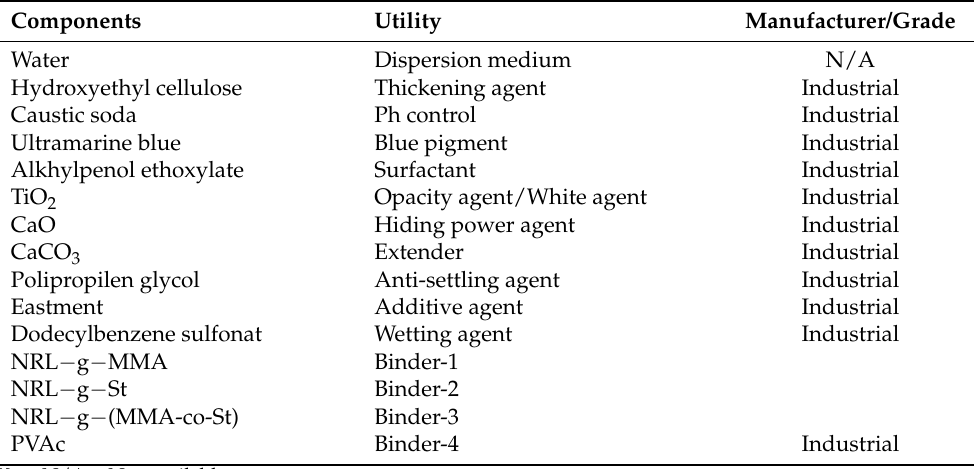
Table 2. Paint components, functions and grades.